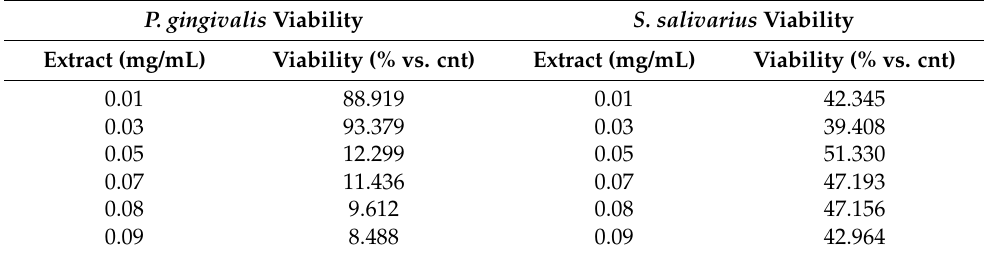
Figure 3. Antibacterial activity of proanthocyanidins (PACN). A different activity was noticed for various concentrations (expressed as mg/mL). For P. gingivalis ( A ) only concentrations >0.03 mg/mL were effective in significantly reducing viability ( p < 0.01, indicated by the *) with results of approximately 10%. By contrast, PACN had moderate effect on ( B ) S. salivarius in comparison to P. gingivalis . Values are represented as the mean ± SD of 16 independent measurements. Table 3. Viability rate of P. gingivalis and S. salivarius after treatment with proanthocyanidins (PACN). Assuming the control as having 100% viability, the survival rate of P. gingivalis resulted in a range between 8% and 88% (left panel) while S. salivarius was between 39% and 51% (right panel).